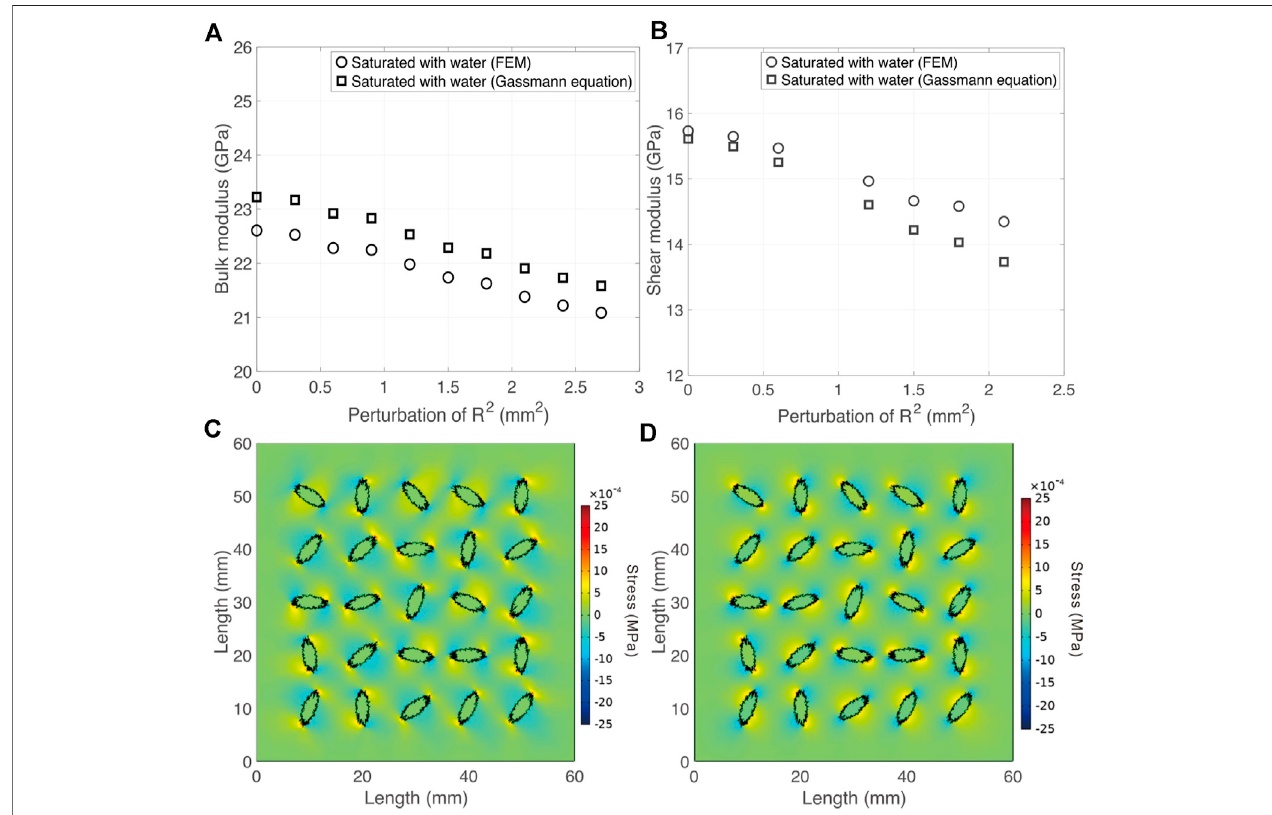
FIGURE 7 | (A) the variation of bulk moduli of water-saturated samples vs. perturbation of R 2 , (B) the variation of shear moduli of water-saturated samples vs. perturbation of R 2 , (C) the distribution of shear stress when the sample loaded by normal stress, (D) the distribution of normal stress when the sample loaded by shear